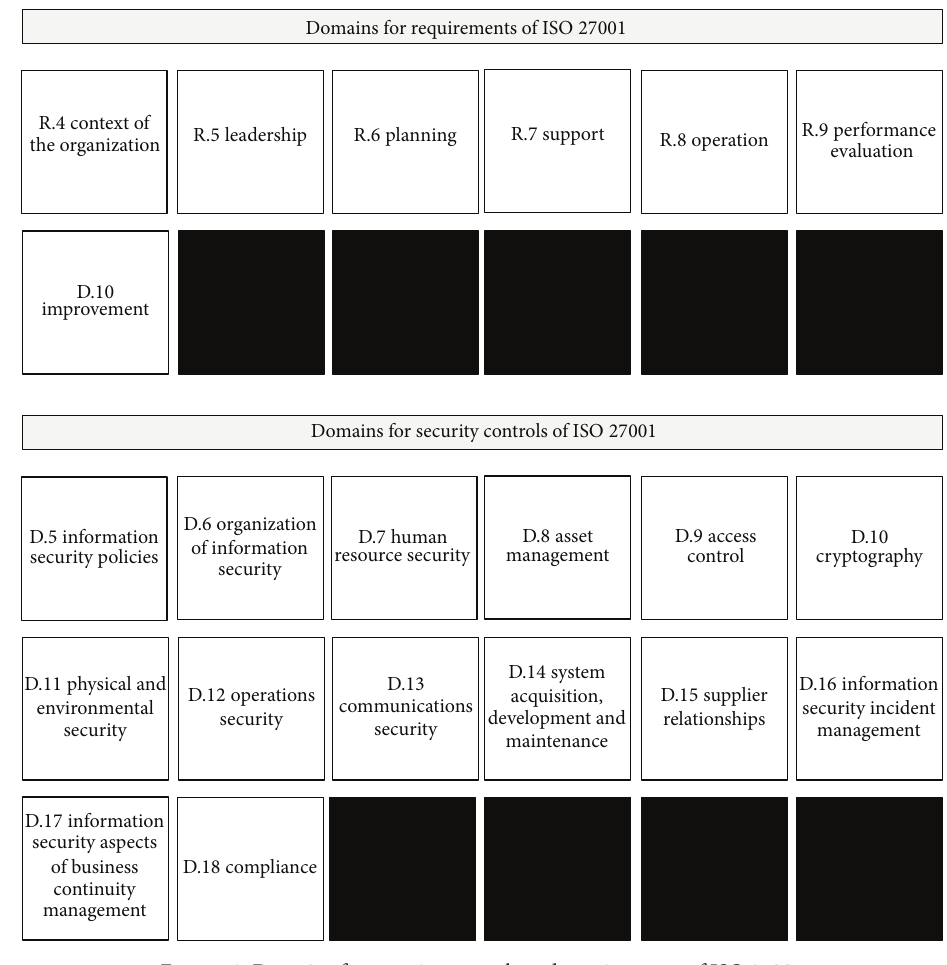
Figure 3: Domains for security controls and requirements of ISO